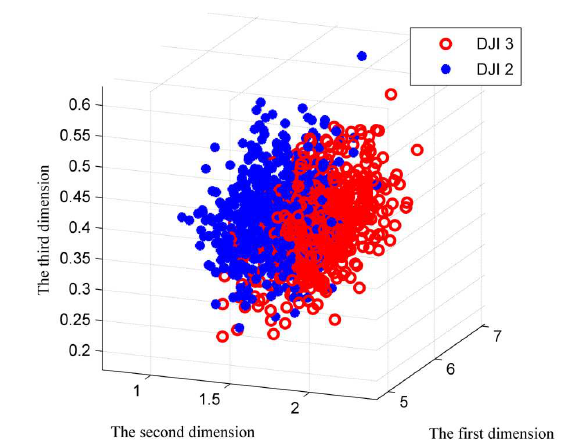
Figure 9. Three-dimensional visualization diagram of PCA-DWT features.